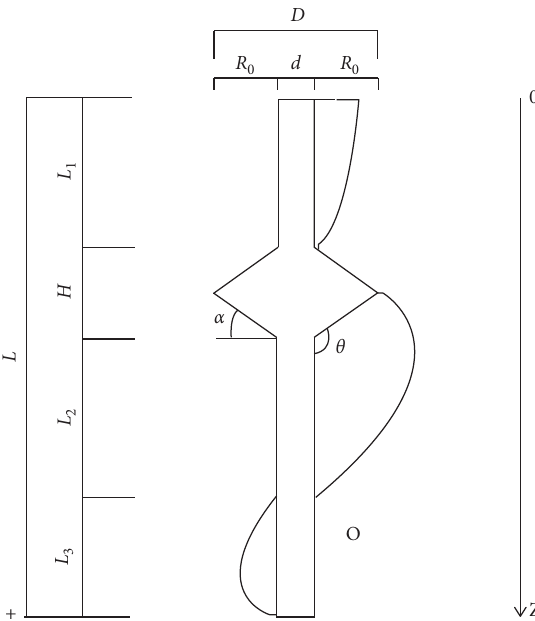
Figure 20: Stress mode of soil around a rigid expanded